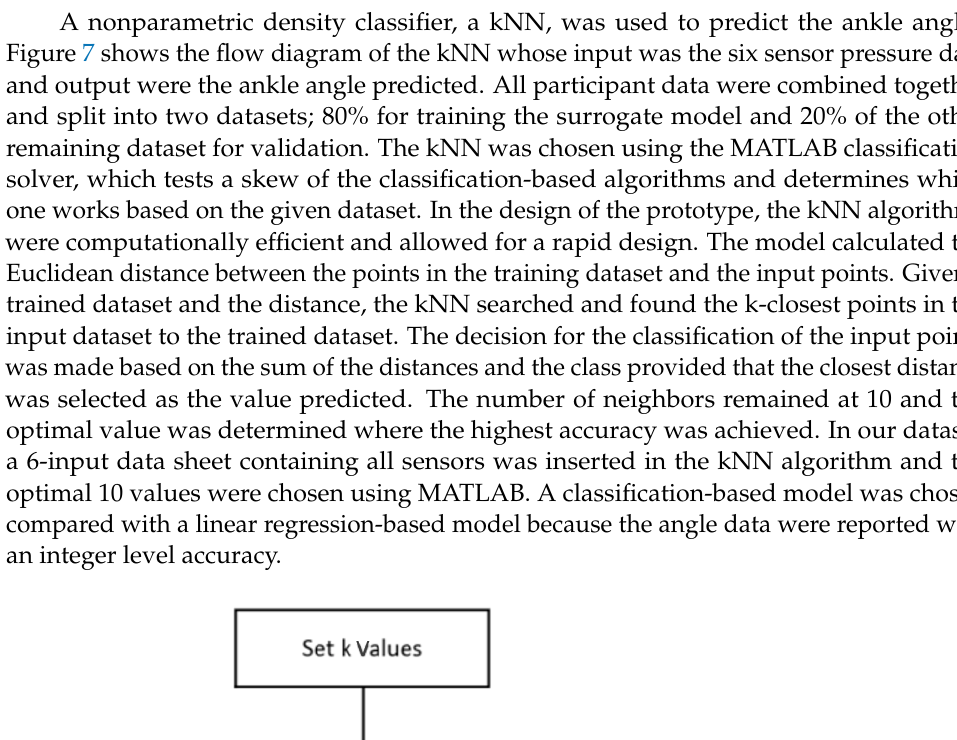
Figure 6. The stoop motion of the experiment with the accompanying sensor readout for the left foot of the movement .